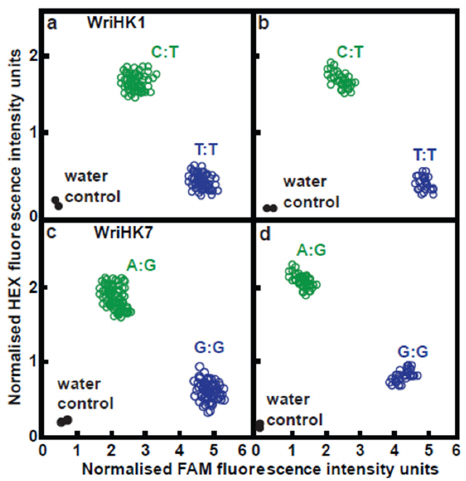
Figure 6. Results obtained with markers 100057258|F|0–6:T > C (WriKH1) and 100061575|F|0–46:G > A (WriHK7) on LG6. For both markers, left panels ( a , c ) show the marker results obtained for 178 H. brasiliensis × H. benthamiana progeny using KASP markers, and right panels ( b , d ) show the marker results obtained for 86 progenies using DArTSeq.